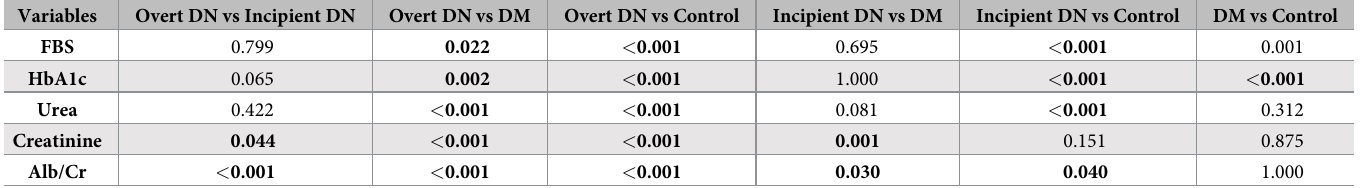
Table 2. Pairwise comparisons regarding clinical laboratory tests of overt DN group, incipient DN group, DM group, and control group versus each other. Variables Overt DN vs Incipient